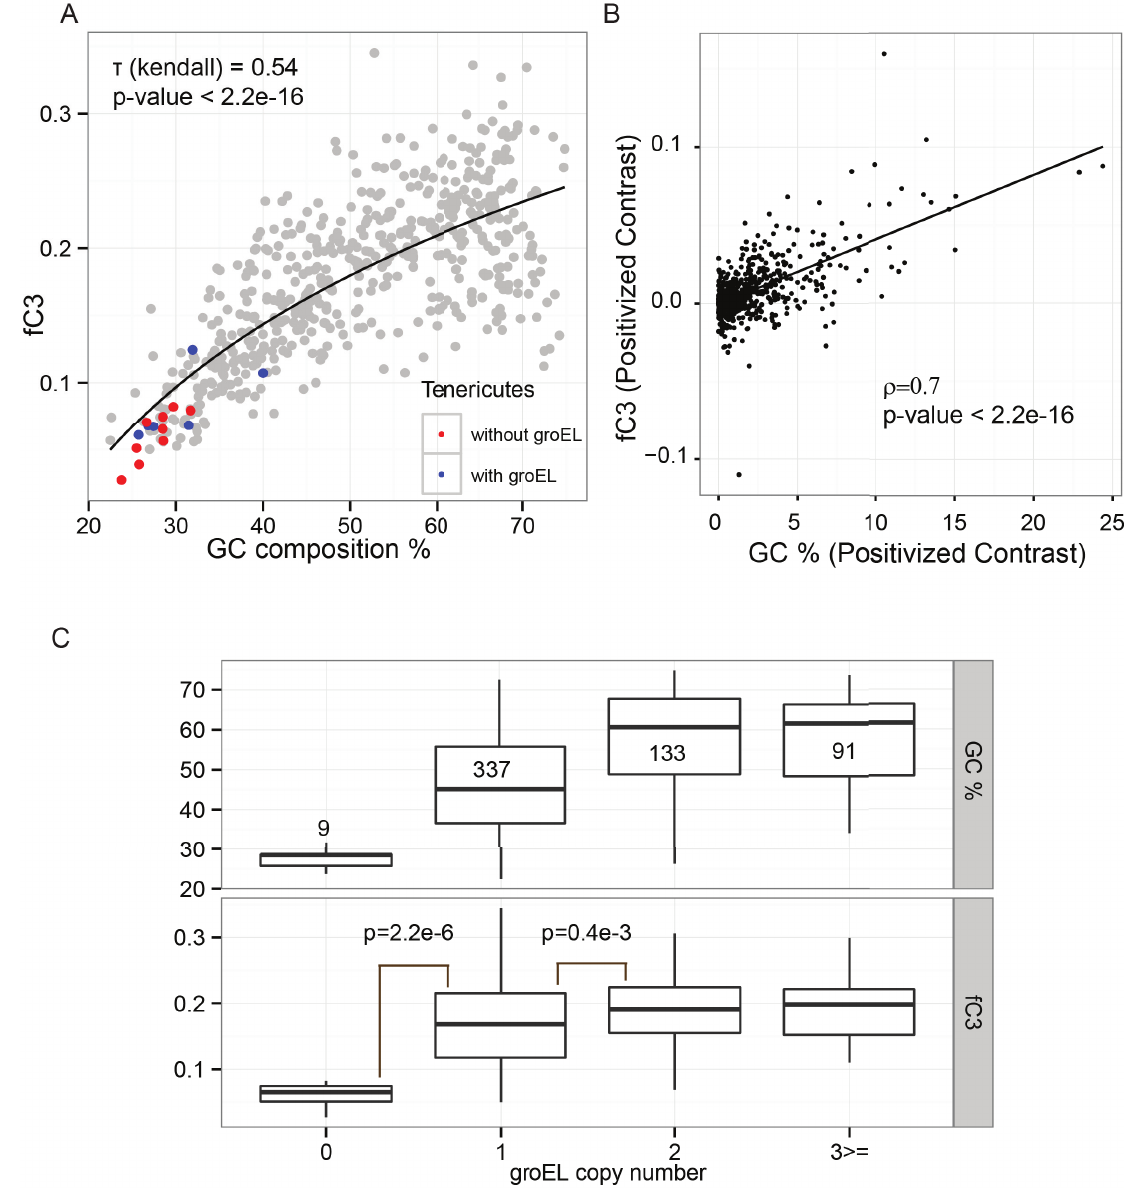
Figure 6. Decrease in GC content is associated with decrease in fC3. ( A ) Correlation of GC content with the fraction of the proteome that is GroEL obligate (fC3) over 570 bacterial genomes. Members of the phylum Tenericutes with and without the groEL gene are coloured in blue and red, respectively. Rank-based correlation is provided along with p-value. The black line shows a logarithmic regression model. ( B ) A positive correlation (0.7) was identified between independent contrast of GC content and fC3 with respect to phylogenetic information of bacterial genomes (570 bacteria, p-value < 2.2e-16). ( C ) The organisms were classified based on the number of groEL genes present in the genome. fC3 exhibited a significant increase with an increase in the number of genome-encoded groEL copies. The p-values were calculated by Mann-Whitney test using two-sided